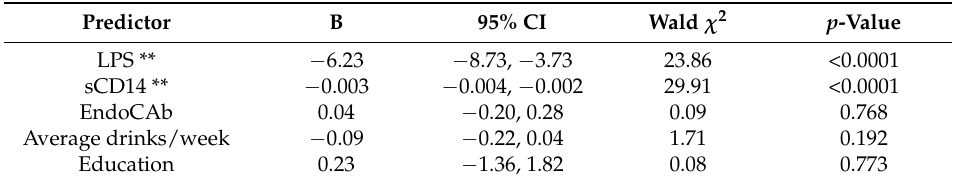
Table 3. Results of GEE model predicting processing speed (WAIS Digit Symbol test) using all immune biomarkers, average weekly drinks, and